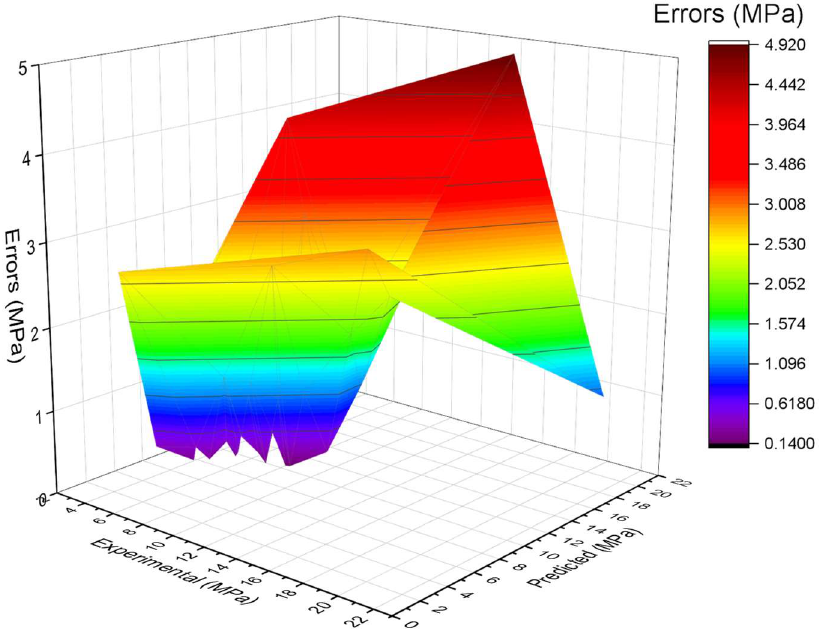
Figure 11. Estimated extreme gradient boosting and experimental values, with errors.